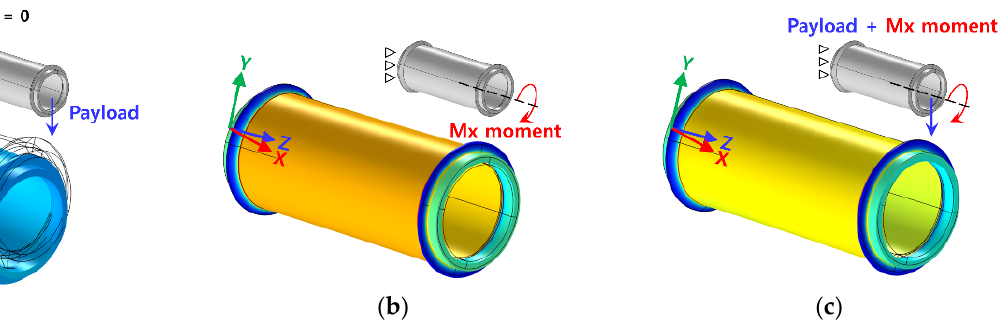
Figure 3. Link dimension selection using structural analysis. ( a ) Stress distribution of link when payload (10 kg, Mz moment) is applied (principle stress: 5.30 MPa, principle strain: 6.27 × 10 − 5 ). ( b ) Stress distribution of link when Mx moment (300 Nm) is applied (principle stress: 15.15 MPa, prin- ciple strain: 2.92 × 10 − 4 ). ( c ) Stress distribution of link when the payload (10 kg, Mz moment) and Mx moment (300 Nm) are applied simultaneously (principle stress: 18.19 MPa, principle strain: 3.11 × 10 − 4 ).